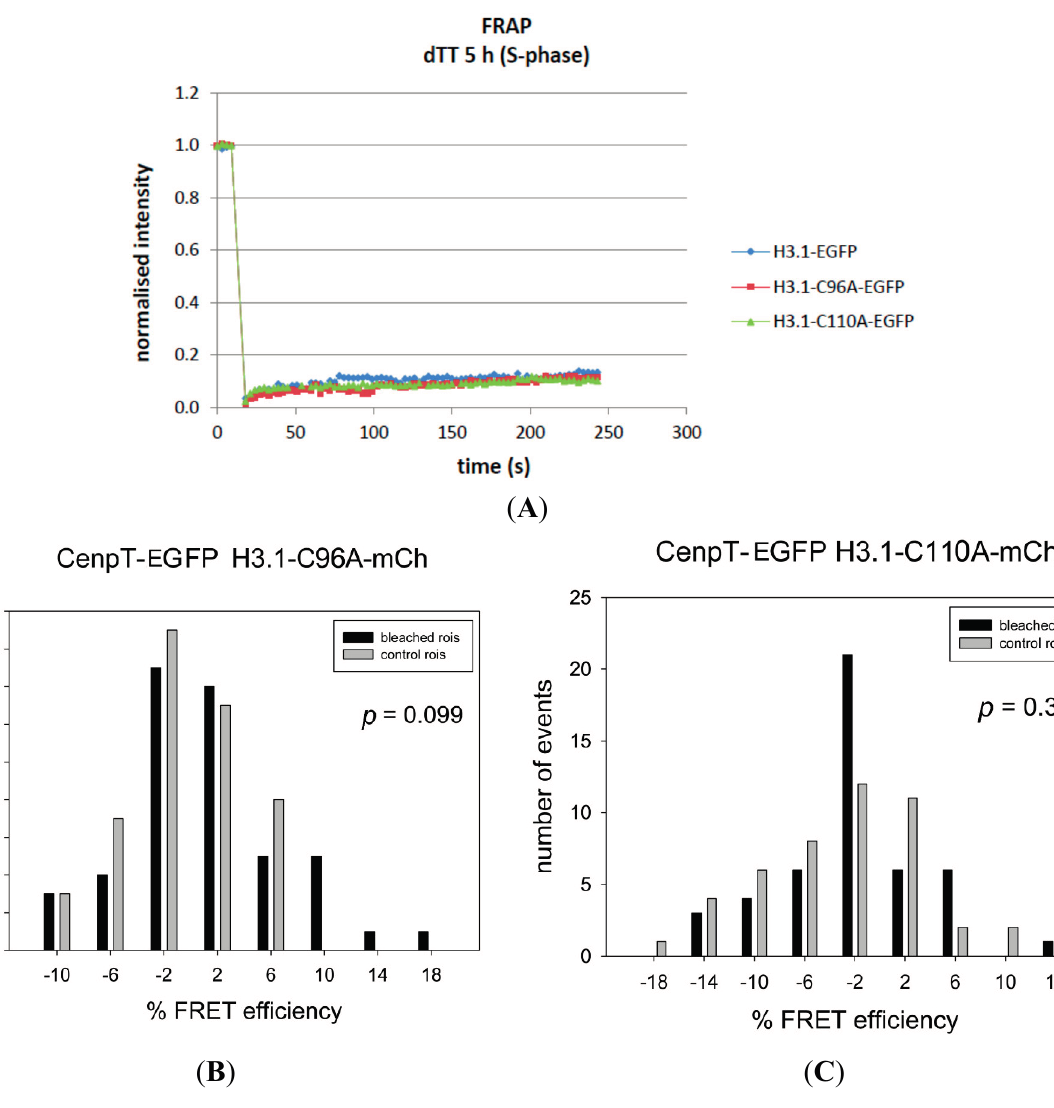
Figure 3. ( A ) Normalized Fluorescence Recovery After Photobleaching (FRAP) recovery curves of H3.1, H3.1 C96A and H3.1 C110A in S-phase (5 h after double thymidine block release) in transfected HeLa cells. All three proteins show the small and slow recovery typical for H3 [107]; ( B , C ) Acceptor-bleaching FRET between CENP-T-EGFP and ( B ) H3.1 C96A -mCherry and ( C ) H3.1 C110A -mCherry. The large p -values indicate the absence of a FRET